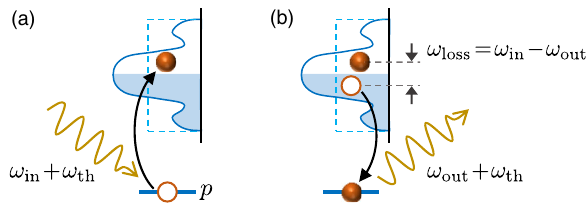
FIG. 7. Schematic depiction of XAS and RIXS. (a) A photon of ω energy ω is absorbed (with absorption threshold ω ), in þ th th transferring an electron from the core level ( p ) to a valence orbital at the same location. For the Mahan impurity model (MIM), the local density of states of the valence orbital is flat (dashed box); for the augmented Anderson impurity model (AAIM), it has structure (solid line), including a Kondo resonance. (b) An electron at the valence orbital relaxes to the core level to fill ω the hole, emitting a photon of energy ω and resulting in out þ th ω − ω an excitation of energy ω in the solid. XAS loss ¼ in out measures the probability for (a) as a function of ω ; RIXS in measures the joint probability for (a) and (b) as a function of ω in and ω loss